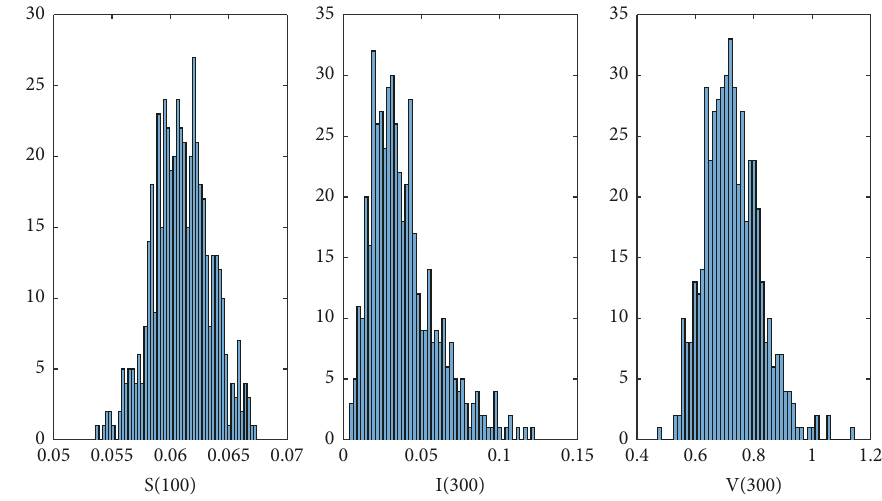
Figure 2: Distribution of 𝑆(300),𝐼(300) , and 𝑉(300) .